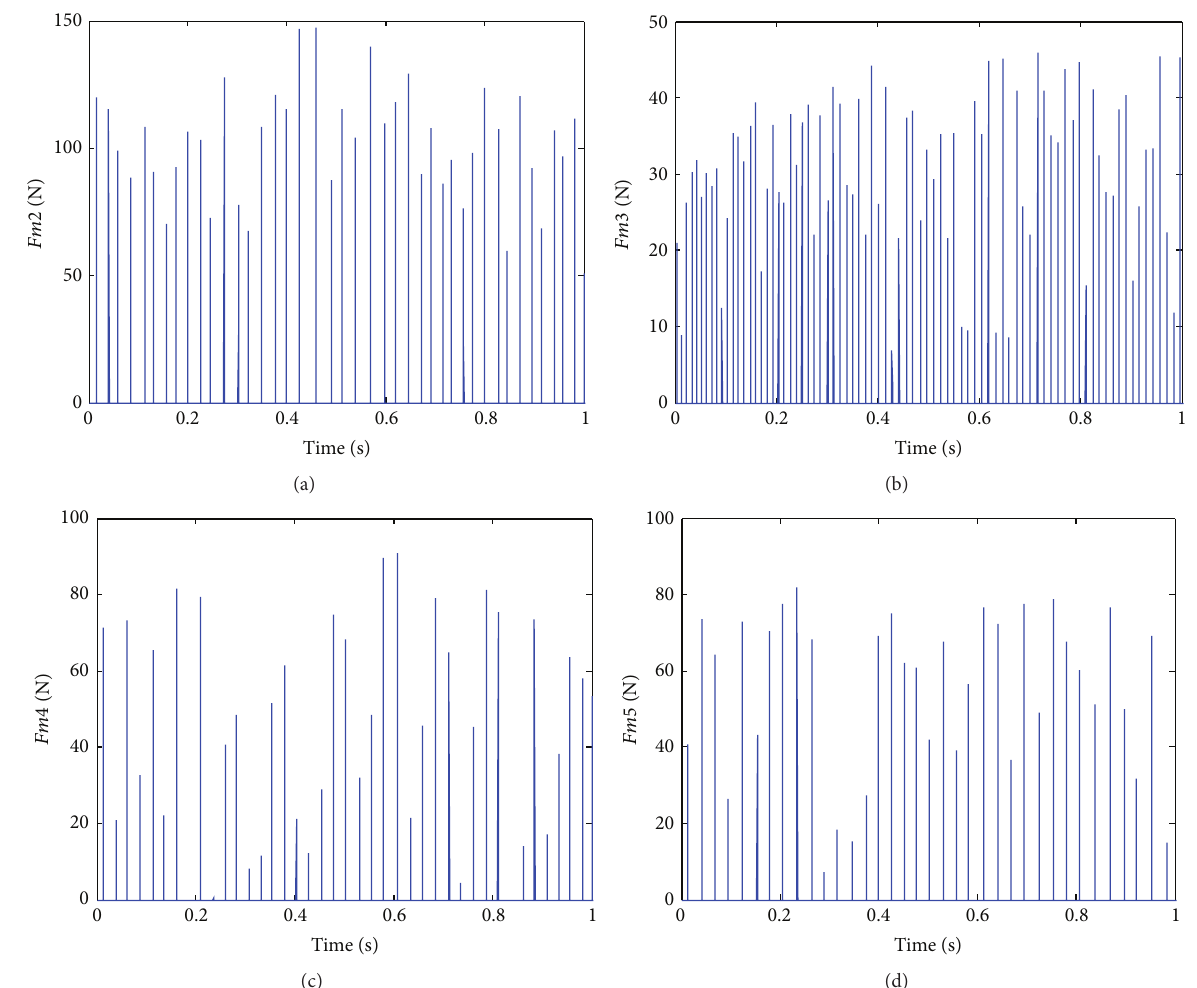
Figure 40: Rattle force of unloaded gear pairs after optimization: (a) the 2nd gear pair, (b) the 3rd gear pair, (c) the 4th gear pair, and (d) the 5th gear